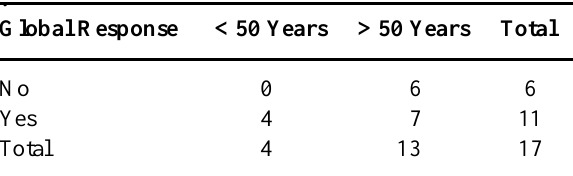
Table 2 – Individuals with peak systolic velocity values = 23 cm/s, according to age and global response.